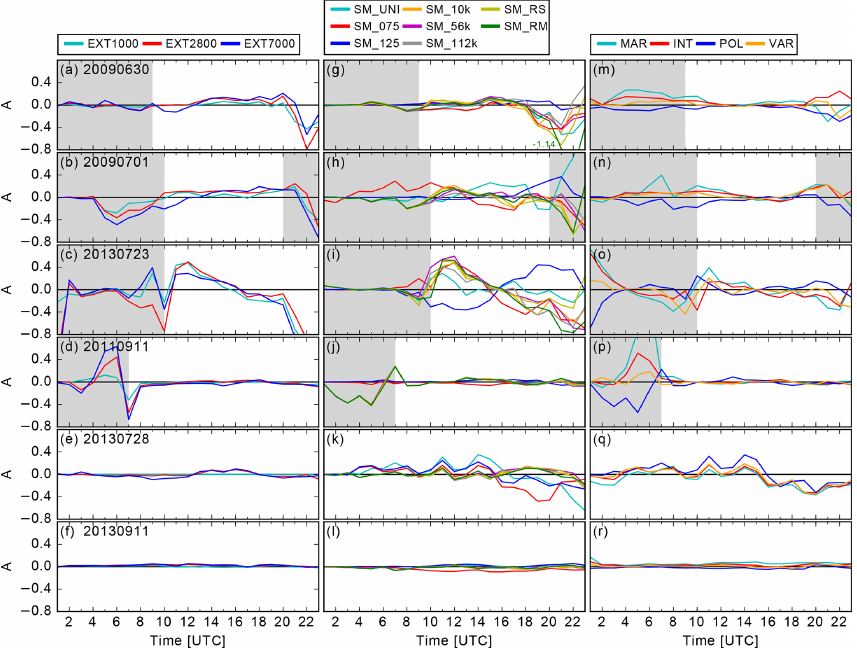
Figure 8. Time series of hourly computed A values for the simulations with modified orography ( a – f ), soil moisture ( g – l ), and aerosols ( m – r ) for the 6 days of investigation. Gray shaded areas are excluded from the computation of daily mean values in Fig. 7.